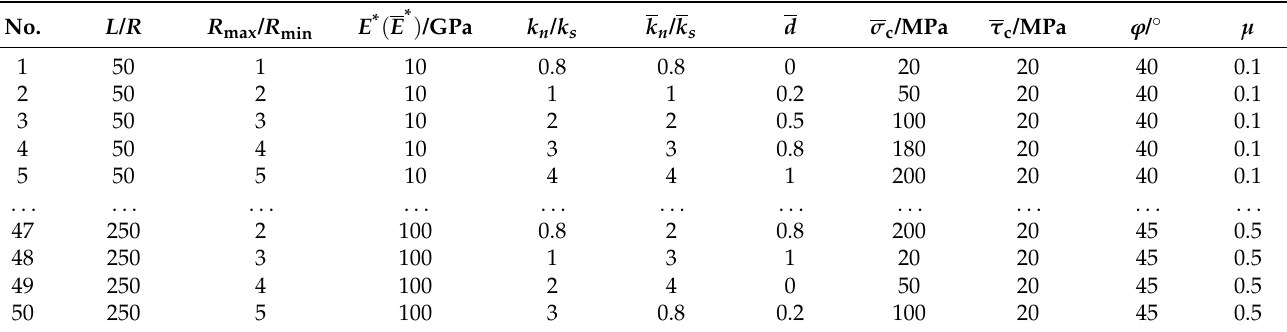
Table 1. Scheme of orthogonal